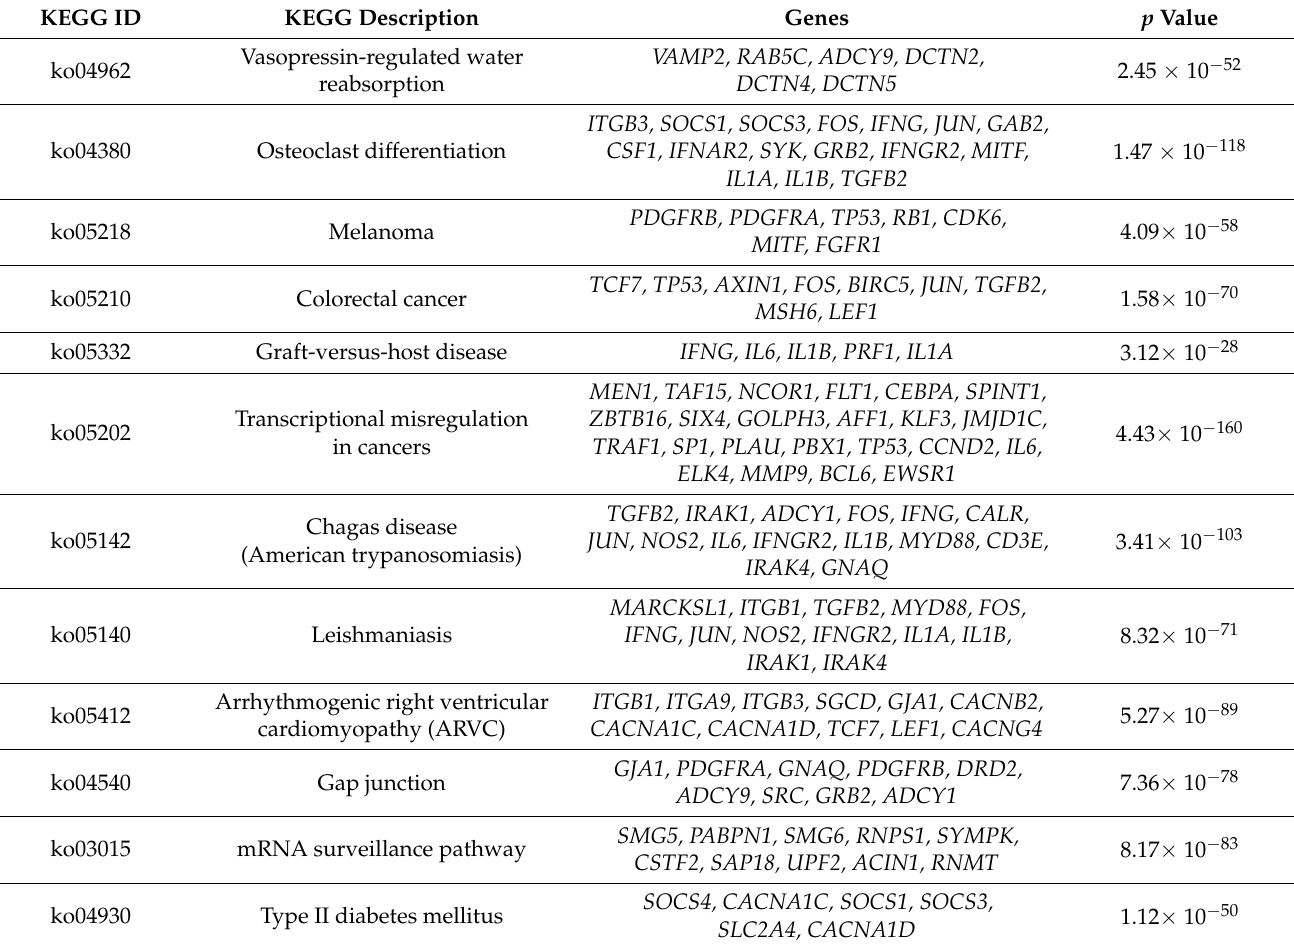
Table 5. Kyoto Encyclopedia of Genes and Genomes (KEGG) pathways analyses of miR-149-5p and its associated genes were extracted from the EVmiRNA: the extracellular vesicles miRNA database.